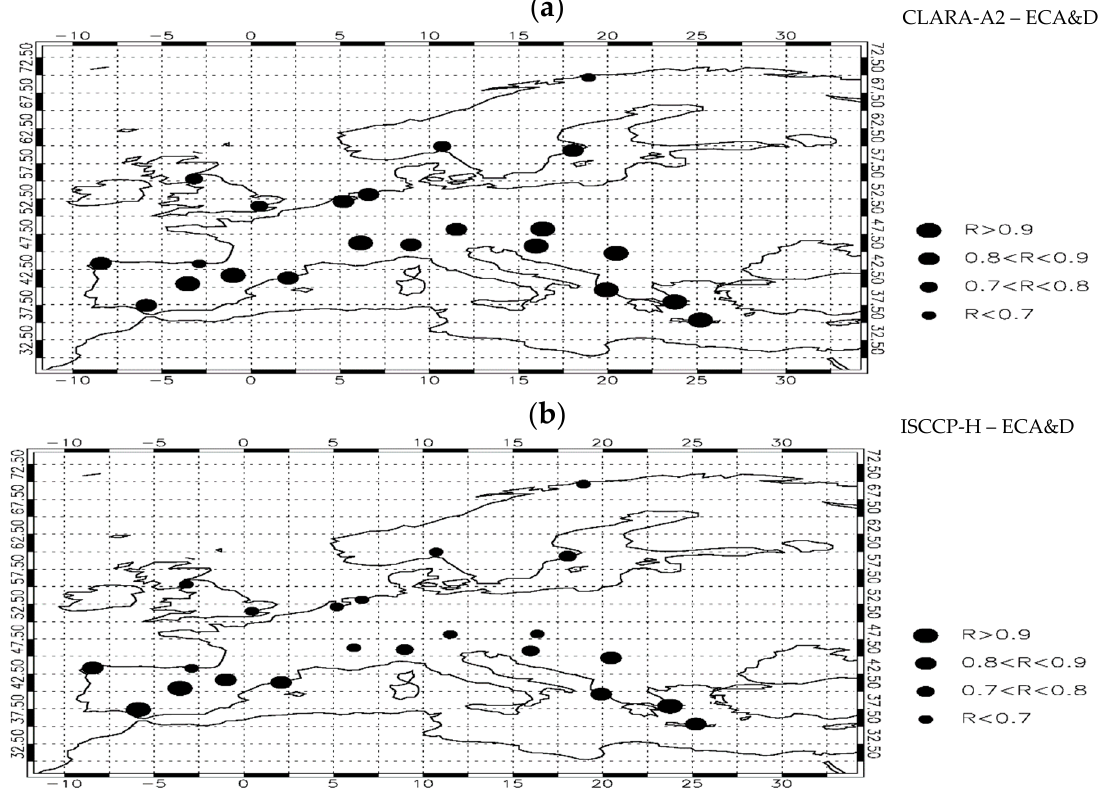
Figure 5. Correlation coefficients between ( a ) CLARA-A2 and ECA&D and ( b ) ISCCP-H and ECA&D TCC values. Correlation coefficient values are given for each one of the 22 selected stations and are increasing with increasing circle